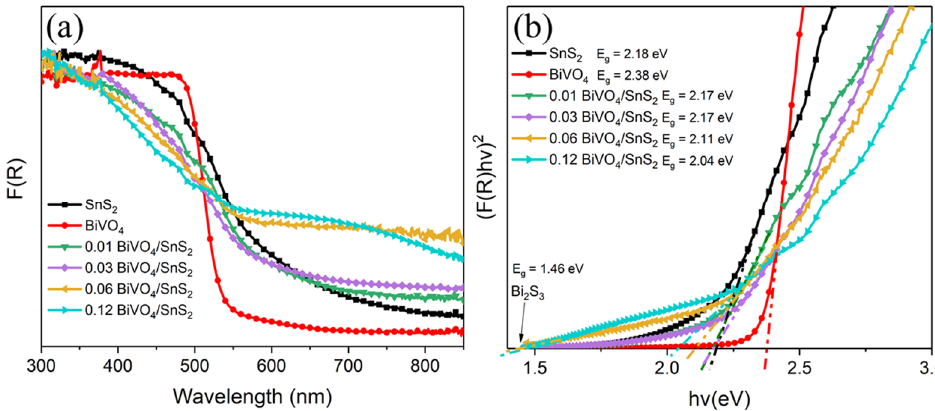
Figure 4. ( a ) UV–Vis diffuse reflectance spectra and ( b ) (F(R)hv) 2 vs. hv plot of SnS 2 , BiVO 4 , and the BiVO 4 / SnS 2 composites with various ratios of BiVO 4 .